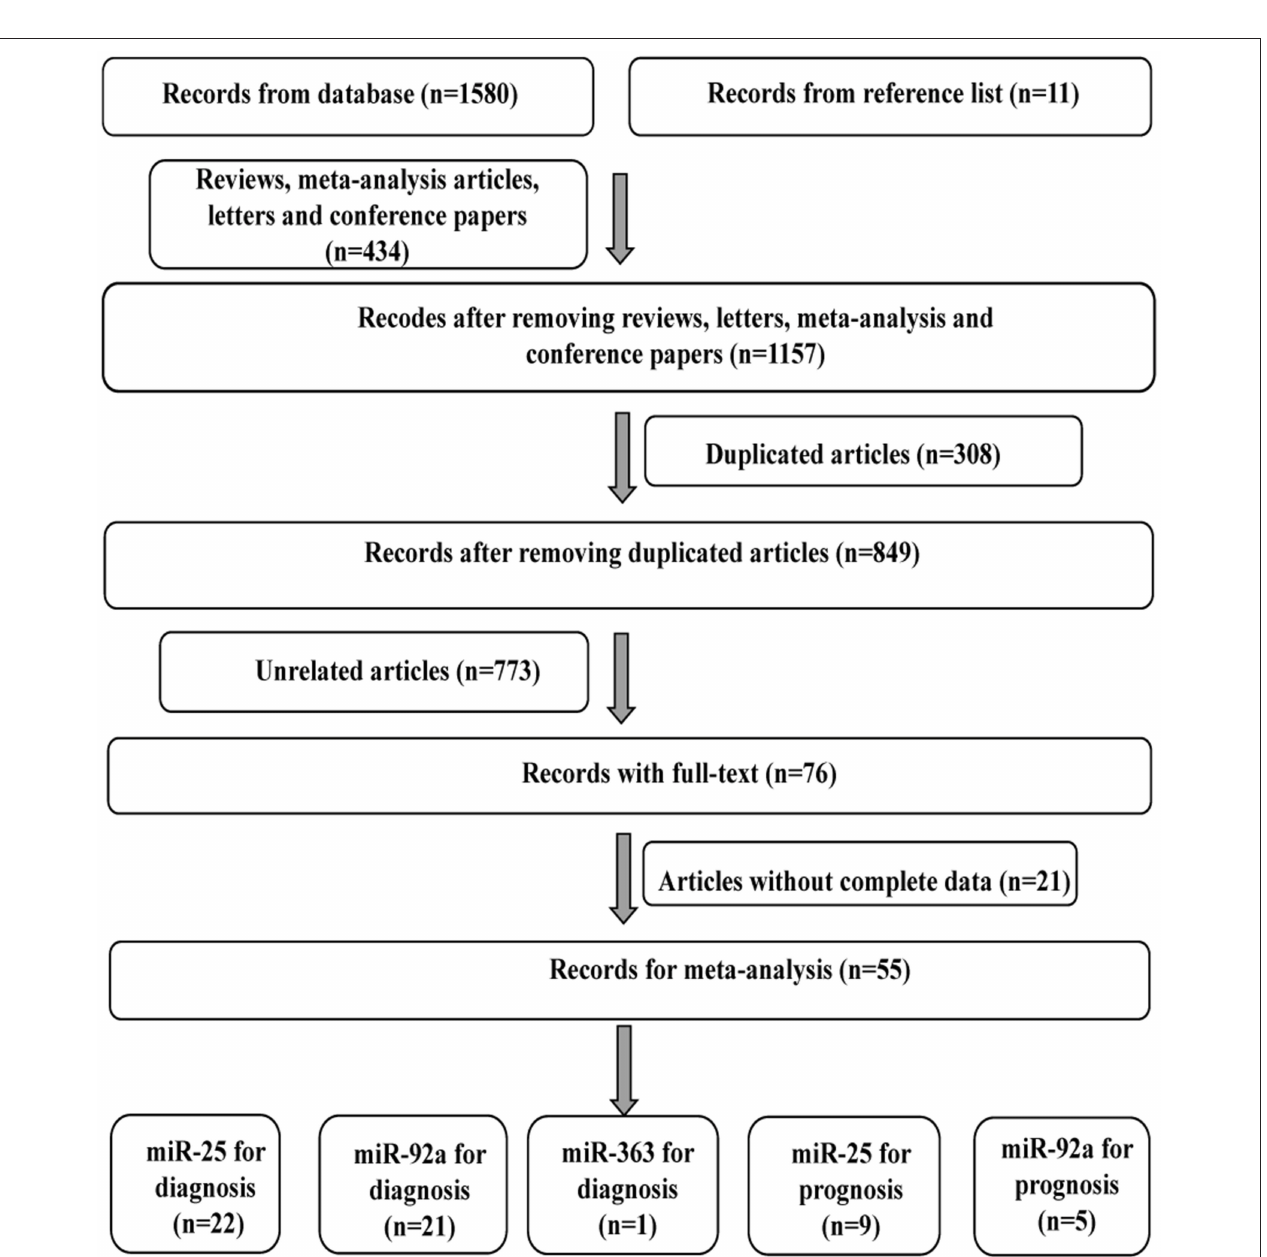
FIGURE 1 | Flow diagram of study selection for cancer diagnostic and prognostic meta-analysis of miR-92a family.